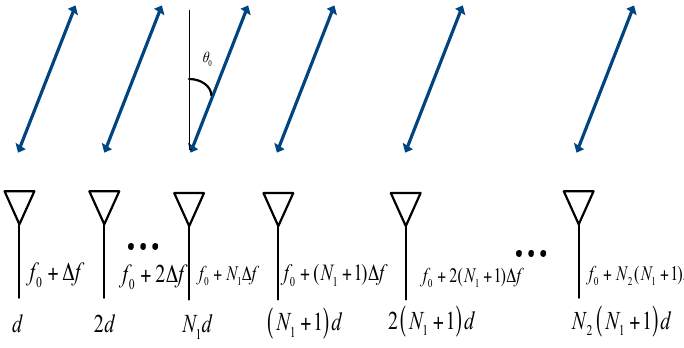
Figure 2. The transmit and receive scheme of NNFDA-MIMO Radar.